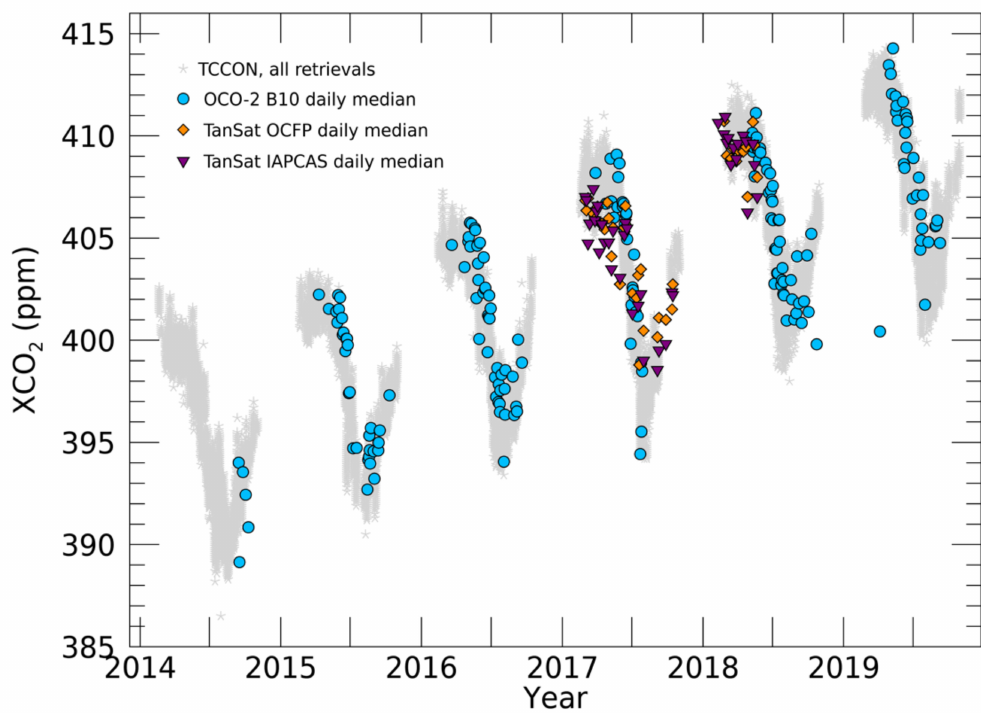
Figure 6. Comparison of XCO 2 retrievals at Sodankylä, in Northern Finland. Ground-based FTS retrievals from the TCCON are presented with gray symbols. Two retrieval products for TanSat (OCFP with orange and IAPCAS with purple) are shown together with OCO-2 B10 XCO 2 (blue symbols). Satellite data are aggregated as daily